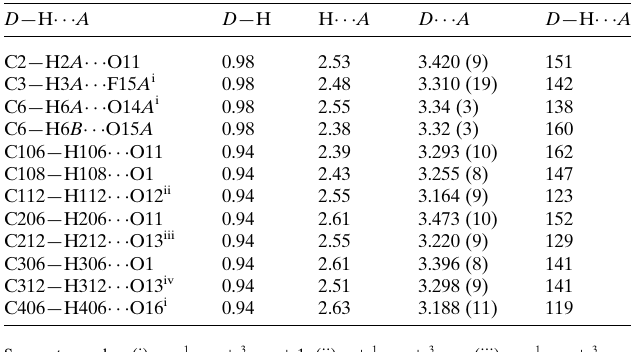
Table 2 Hydrogen-bond geometry (A˚ , (cid:3) ) for 3 .